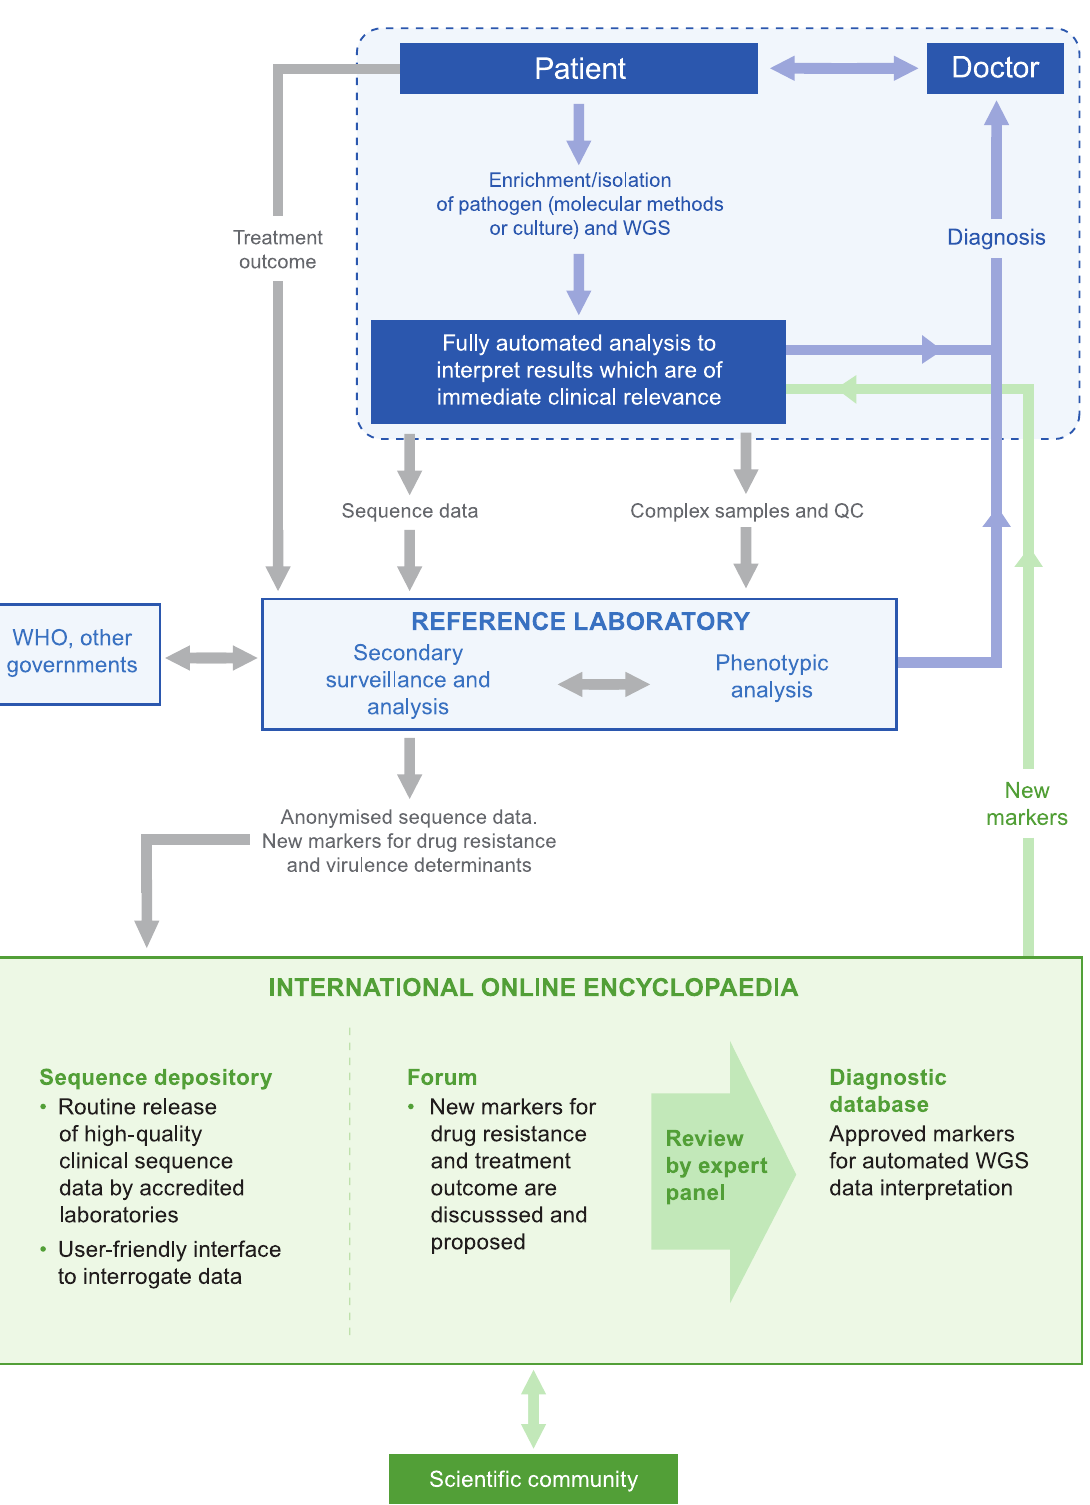
Figure 2. Overview of pathogen WGS data interpretation and use. After an enrichment step for pathogen DNA via culture or direct molecular enrichment/amplification (e.g. by RT-PCR for HIV) from the clinical sample, WGS could be performed in regional sequencing hubs. Fully automated analysis software would extract information of immediate clinical importance (i.e. an epidemiological analysis, susceptibility testing, and/ or the precise identity of the pathogen). The results would be presented such that no knowledge of genomics would be required. Only in cases of new and emerging types of concern, where the genotype-phenotype relationship was unclear, or for quality control (QC) purposes would samples be sent for analysis by reference laboratories. Reference laboratories could routinely make anonymised sequence data available in the first part of an